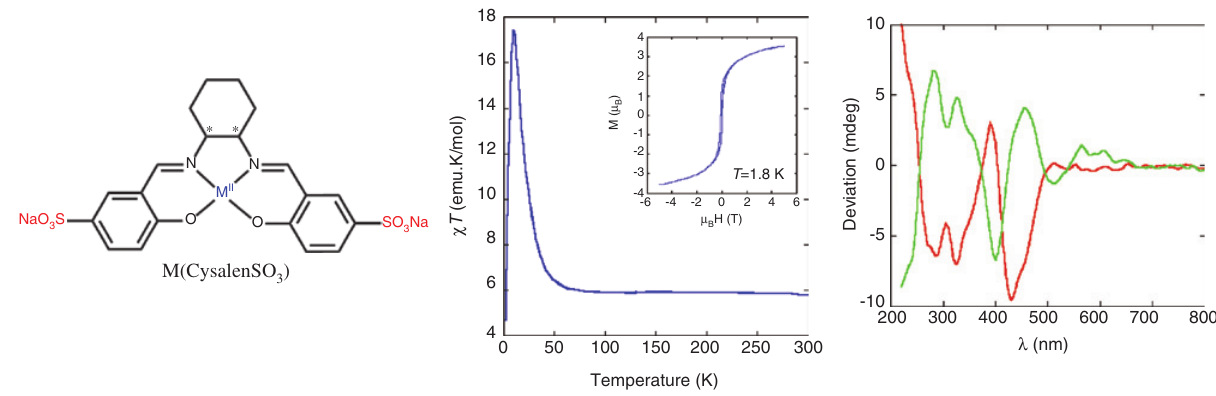
Figure 20: Salen complexes derived from hexane diamine bridge (M = Co(II), Ni(II), Cu(II), Zn(II)). Magnetic behavior as a function of the temperature of the compound Ni(SalenSO )@Co. Circular dichroism spectra (solid phase) for compounds Ni(CysalenSO 3 and Ni(CysalenSO ( SS ))@Cu (red). Adapted with permission from [140]. Copyright 2010 Société Chimique de 3